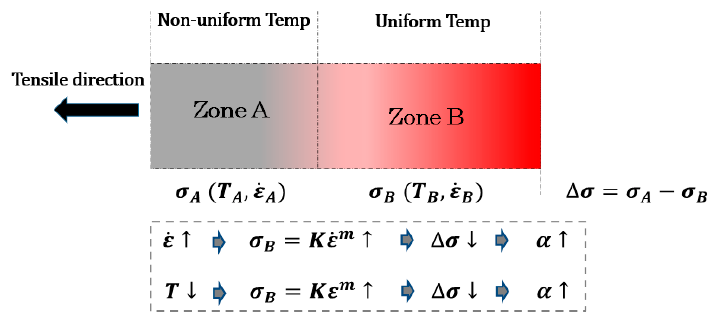
Figure 8. Schematic illustration of the angle